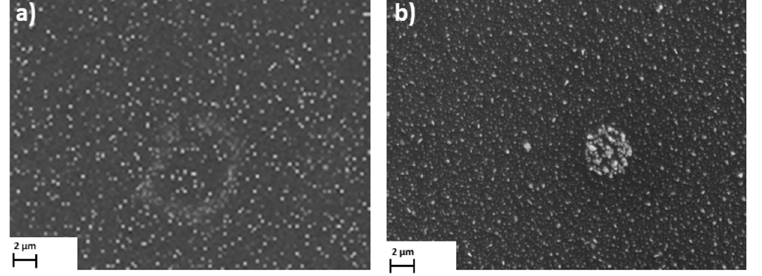
Figure 13. SEM images of [Cu 2 (EtNH 2 ) 2 (µ-O 2 CC 3 F 7 ) 4 ] ( 3 )/Si ( a ) before, ( b ) after heating Mag = 10,000× (1100 rpm, 30 s).